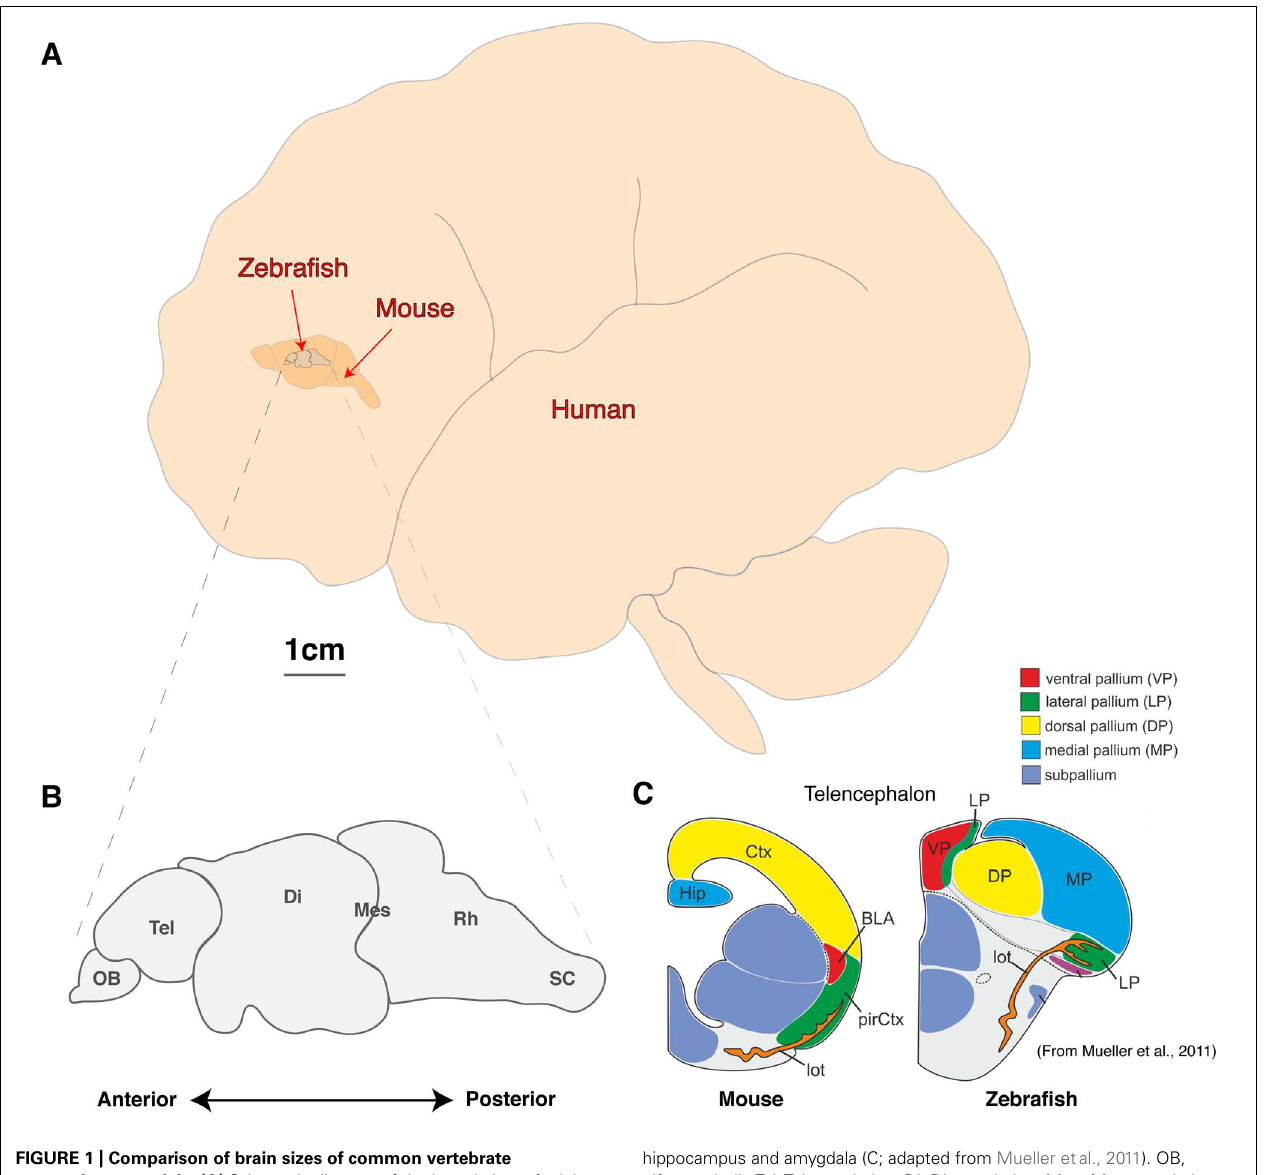
hippocampus and amygdala (C; adapted from Mueller etal., 2011). OB, olfactory bulb;Tel,Telencephalon; Di, Diencephalon; Mes, Mesencephalon; Rh, Rhombencephalon; sc, Spinal cord; Ctx, Neocortex; Hip, Hippocampus, pirCtx, Piriform cortex; BLA, Basolateral Amygdala and lot, lateral olfactory